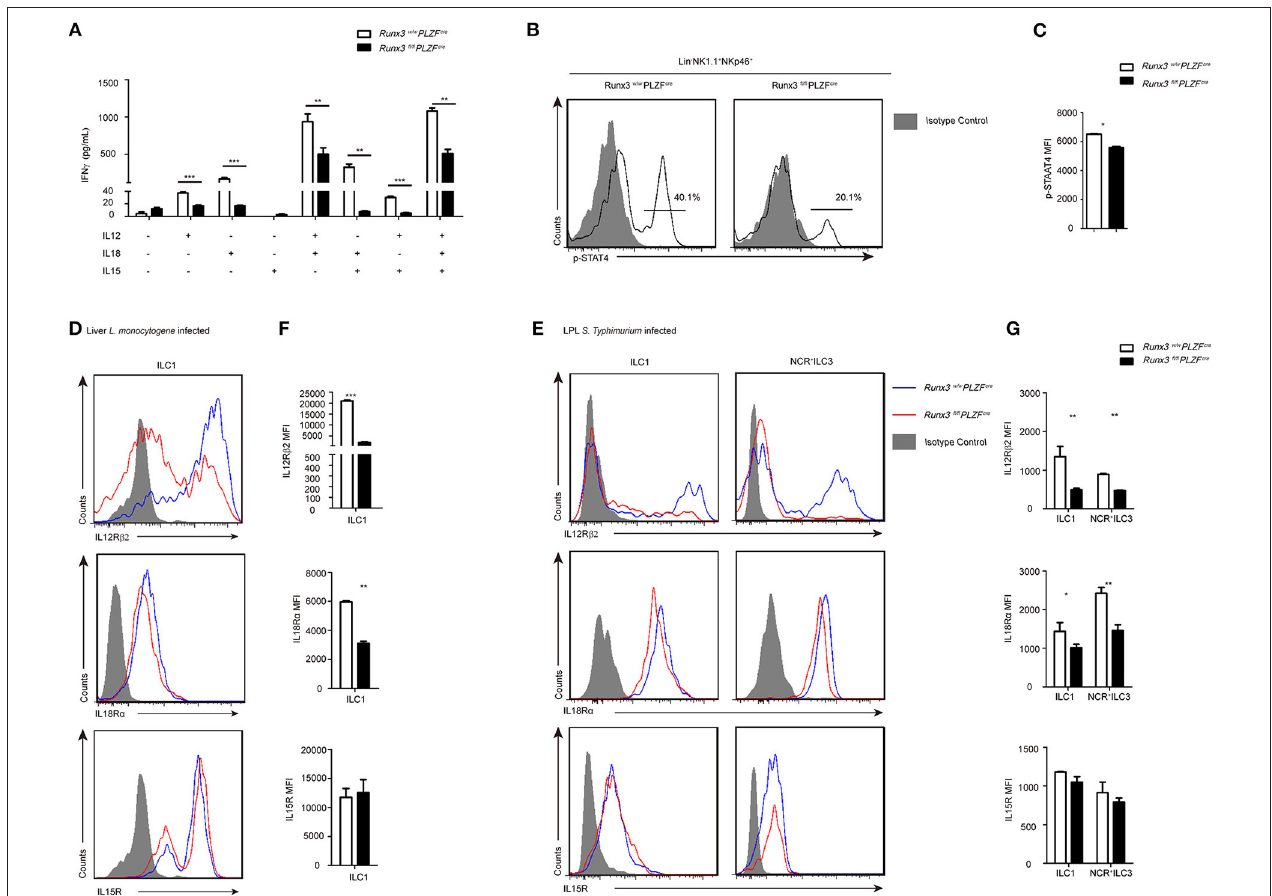
FIGURE 5 | The IL12R signaling pathway was defective after Runx3 deletion in ILC1s and NCR + ILC3s. (A) ELISA for IFN γ secretion by intestinal ILC1s from wild type and Runx3 KO mice after stimulation with the indicated cytokines labeled under each bar for 36h. (B) Flow cytometry assay of p-STAT4 in intestinal ILC1s from wild type and Runx3 KO mice after stimulation with IL12. (C) Statistical analysis of the change of p-STAT4. (D,F) Wild type and Runx3 KO mice were infected with L. monocytogenes through tail vein injection ( n = 3 per group). (D) The expression of IL12R β 2, IL18R α and IL15R in ILC1s from the liver after L. monocytogenes infection and (F) mean fluorescence intensity (MFI) of the indicated proteins in ILC1s. (E,G) Control and Runx3 KO mice were orally infected with S. typhimurium ( n = 6 per group). (E) The expression of IL12R β 2, IL18R α , and IL15R on ILC1s and NCR + ILC3s from the small intestine after S. typhimurium infection and (G) mean fluorescence intensity (MFI) of the indicated proteins in ILC1s and NCR + ILC3s (mean ± SD of three samples in (A,C,F,G) ; * P < 0.05, ** P < 0.01 and *** P < 0.001 by Student’s t -test). Data are from one experiment representative of three independent experiments with similar results in (A–C) and four independent experiments with similar results in (D–G)